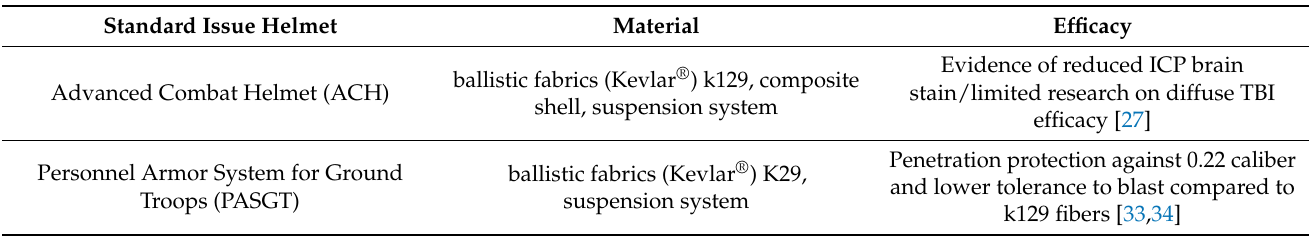
Table 3. Military